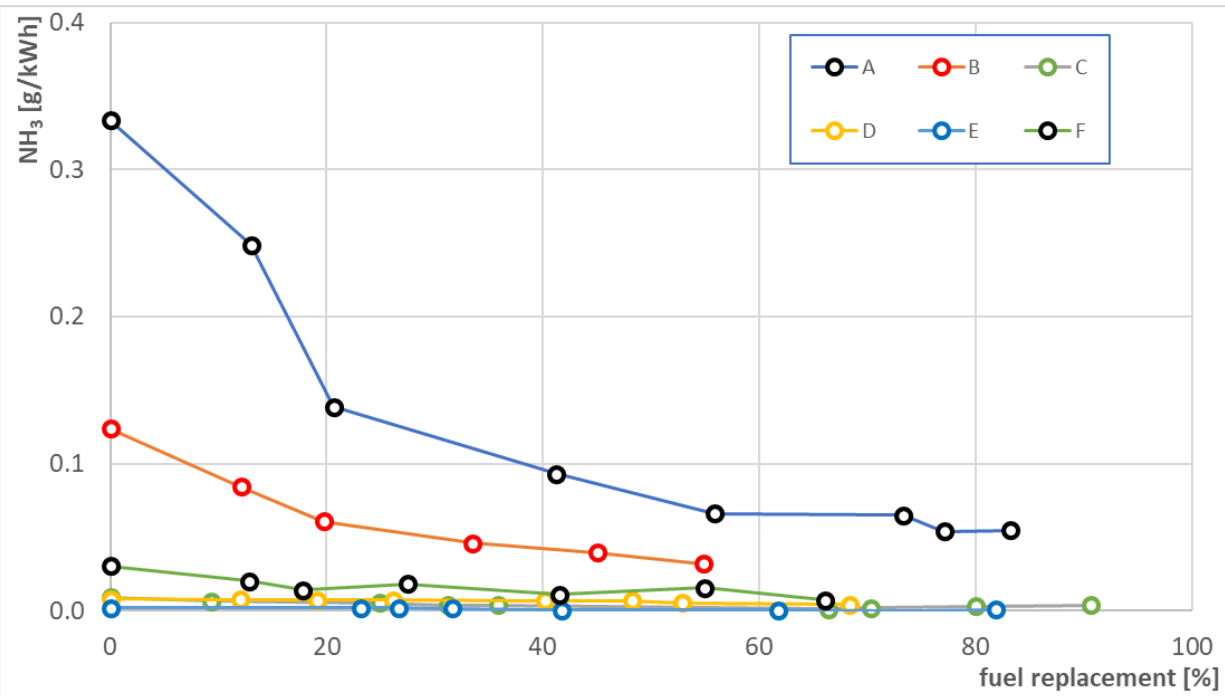
Figure 19. Curves from A to F showing engine’s emission of NH 3 (ammonia), for individual engine operating points, where the rotation speed, power, and torque were constant, as a replacement function of diesel fuel replaced by CNG.